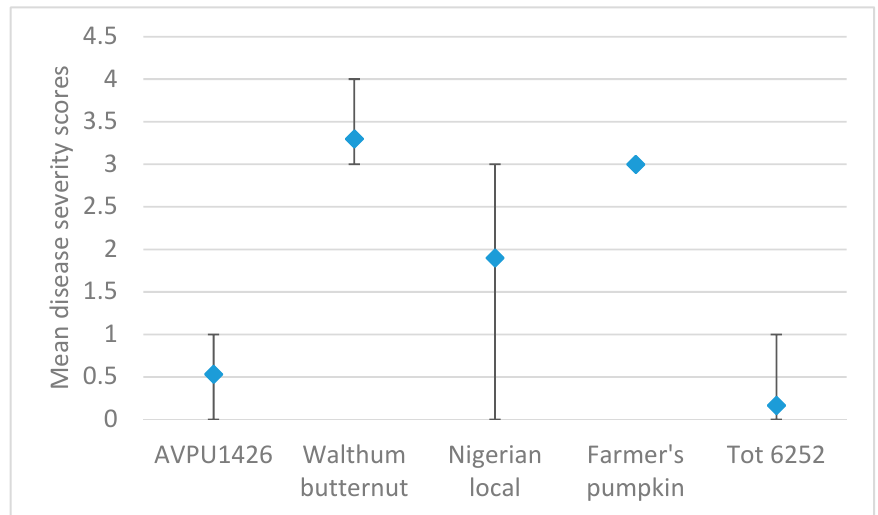
Figure 2. Comparison of disease severity scores for 30 plants each of AVPU1426 and four control varieties after challenge with SLCPV-TW for two weeks in the net-house in Taiwan (diamonds = overall mean and vertical lines represent the range between the minimum and maximum disease scored for each line).